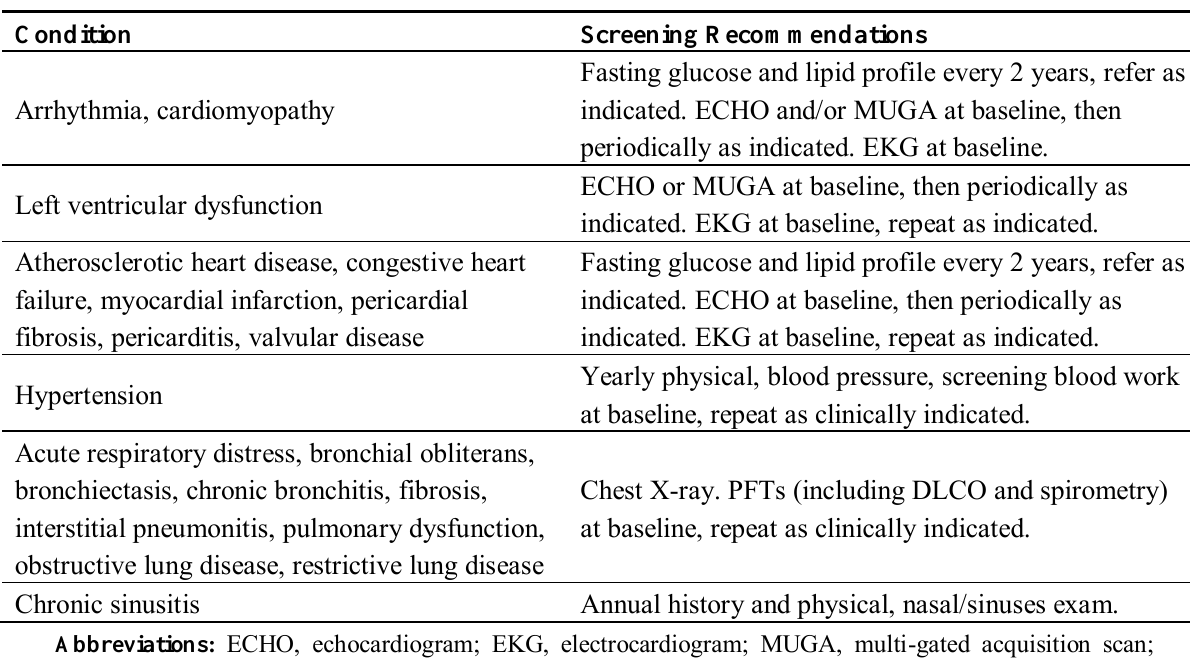
Table 2. Screening recommendations for cardiopulmonary late effects according to the Children’s Oncology Group Long-Term Follow-Up